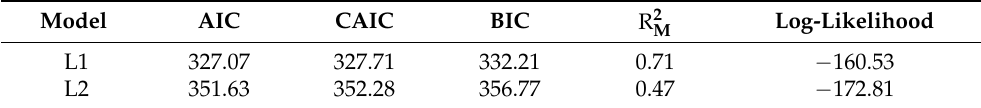
Table 10. Values of AIC, BIC, CAIC, and log-likelihood function for Weibull median-regression models with the data of time to electrical breakdown of an insulating fluid.